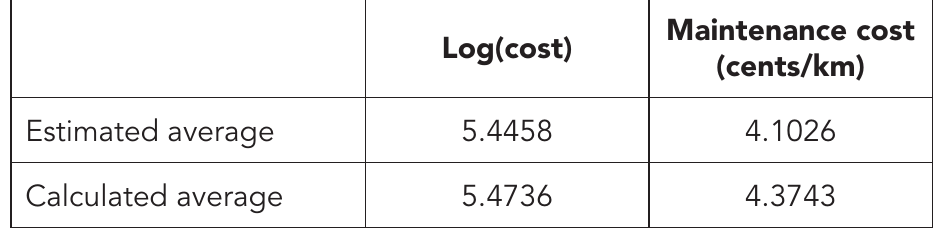
The maintenance cost evaluation indicates that the proposed methodology resulted in a 0.28 cents/km (6.3%) underestimation on average of the ‘true’ average maintenance cost for the vehicle